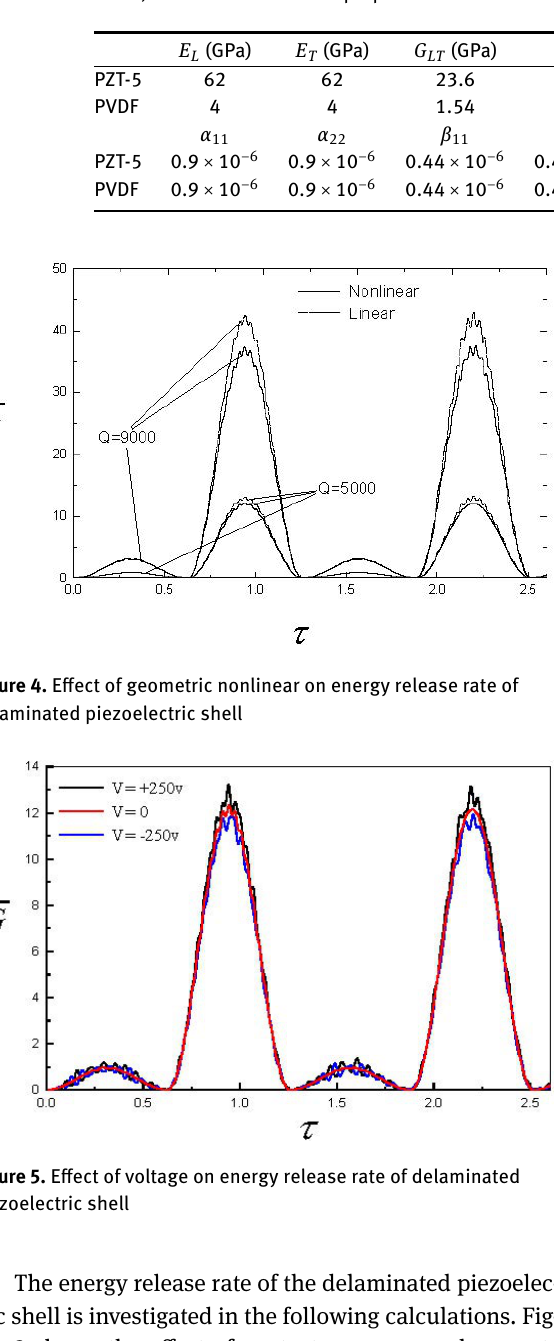
Table 1. Mechanical, electrical and thermal properties of PZT-5 and PVDF